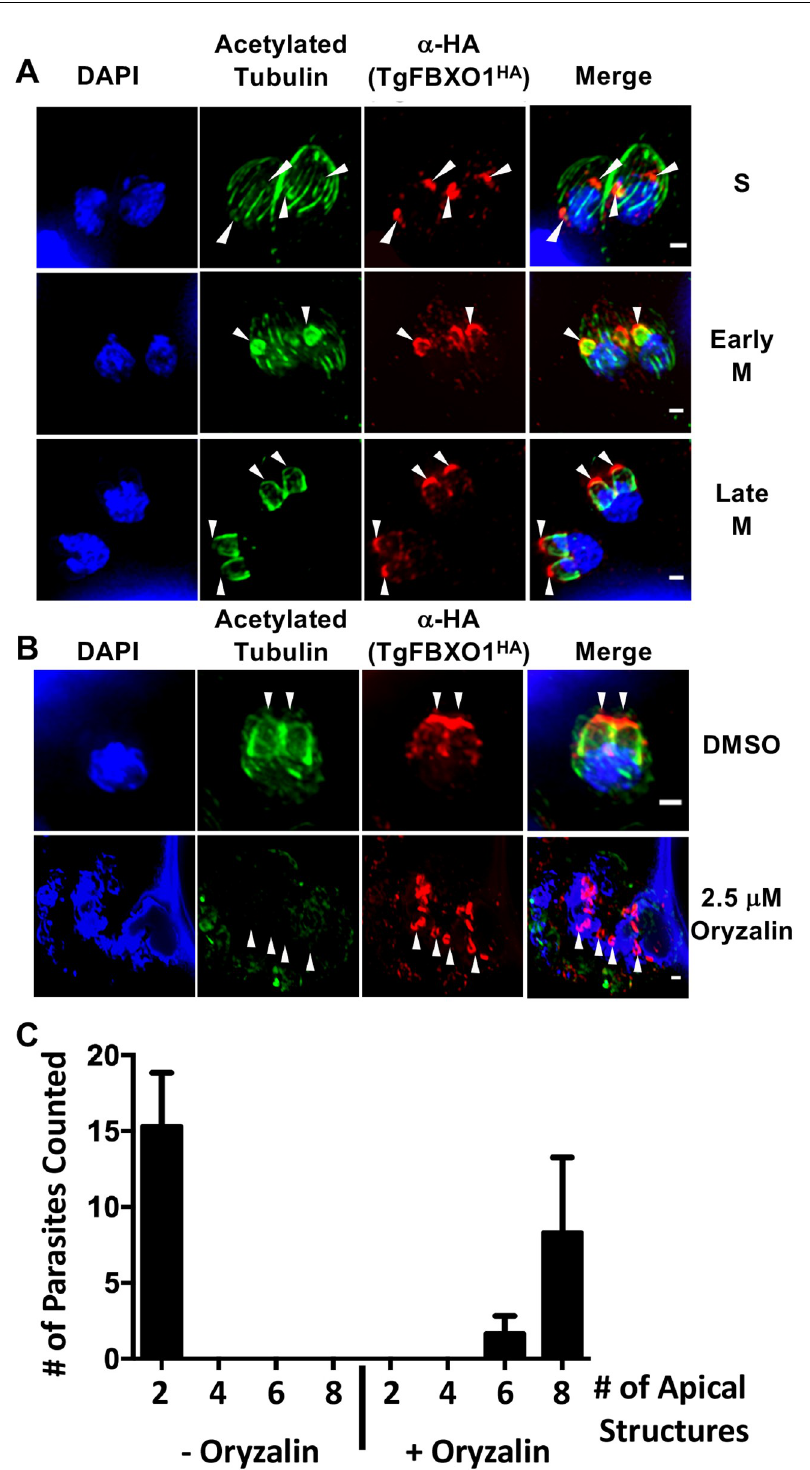
Fig 5. TgFBXO1 apical structures form independently of daughter cell microtubule assembly. (A) . TgFBXO1 HA - expressing parasites were stained to detect TgFBXO1, acetylated tubulin (to detect newly synthesized microtubules), and DNA during S, early M, and late M (during nuclear segregation) phases. Bars = 2 μ m. (B) . Parasites were treated with oryzalin (2.5 μ M) or DMSO (vehicle control) for 24 h and then stained to detect TgFBXO1, acetylated tubulin, and DNA. Arrowheads highlight TgFBXO1 apical structures. Bars = 2 μ m. (C) . Quantification of numbers of TgFBXO1 HA structures per parasite that form in the presence of DMSO or oryzalin. Shown are the averages and standard deviations of 3 independent experiments in which 50 randomly selected parasites were